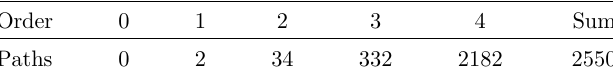
Table 1. Number of valid paths with re fl ection and diffraction components for each order found by the Keller approach of the path fi